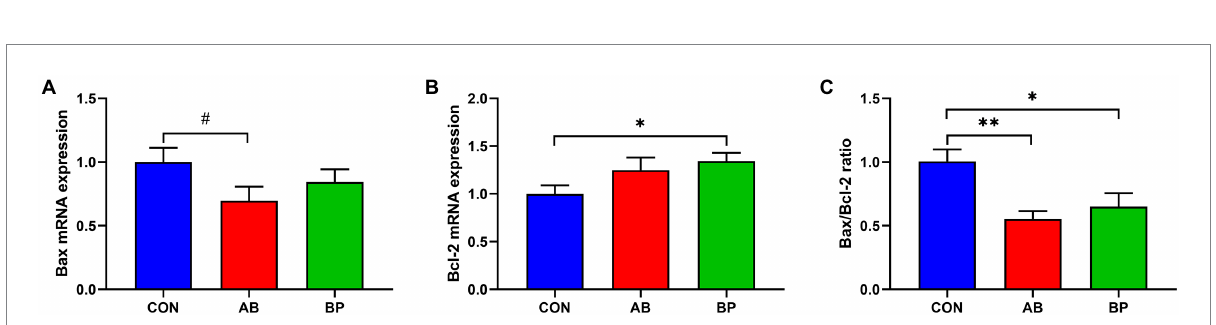
FIGURE 10 Effects of dietary supplemented with Bopu powder on expressions of apoptosis genes in intestine of broiler chickens. (A) Bcl-2 associated X ( Bax ); (B) B-cell lymphoma-2 ( Bcl-2 ); (C) Bax/Bcl-2 ratio. CON group, broiler chickens fed a basal diet; AB group, broiler chickens fed a basal diet supplemented with 50 mg/kg aureomycin; BP group, broiler chickens fed a basal diet supplemented with 40 mg/kg Bopu powder containing protopine and allocryptopine. Values are mean ± standard error ( n = 6). # 0.05 ≤ p < 0.10, * p < 0.05, ** p <